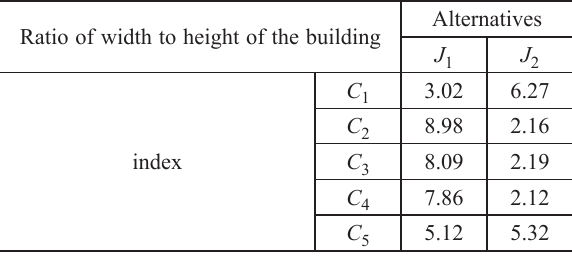
Table 18. Averages of experts’ scores for alternatives of the ratio of width to height of the building within the major index Ratio of width to height of the building